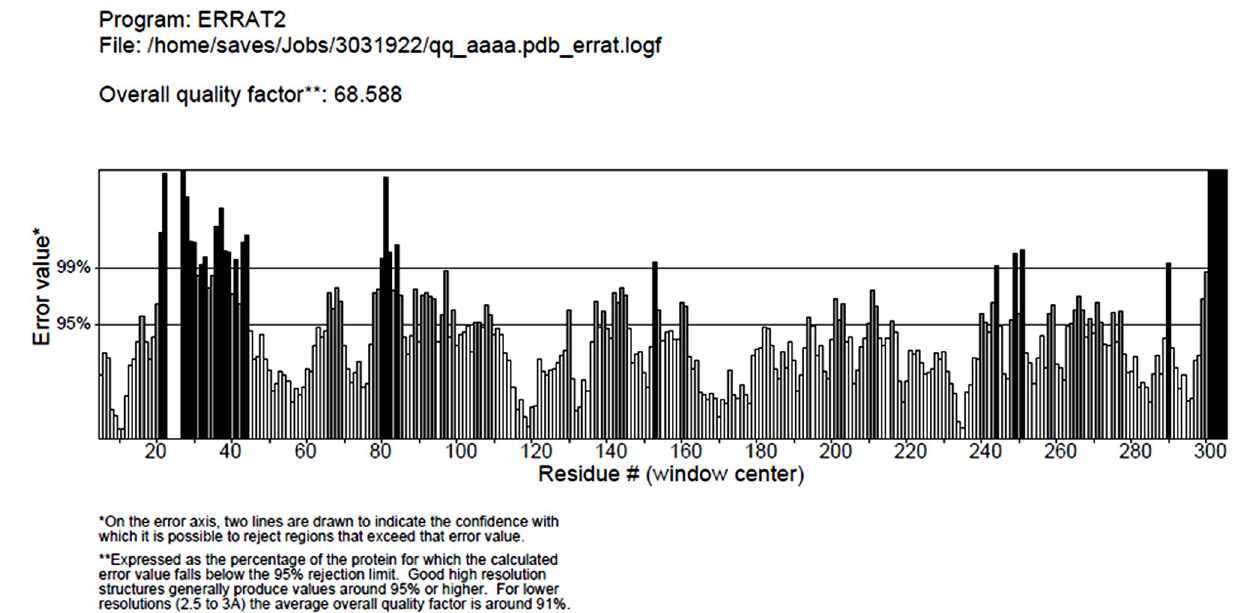
Fig 10. ERRAT measurement of nrtC protein. Values indicate over all structure quality of the traget protein.